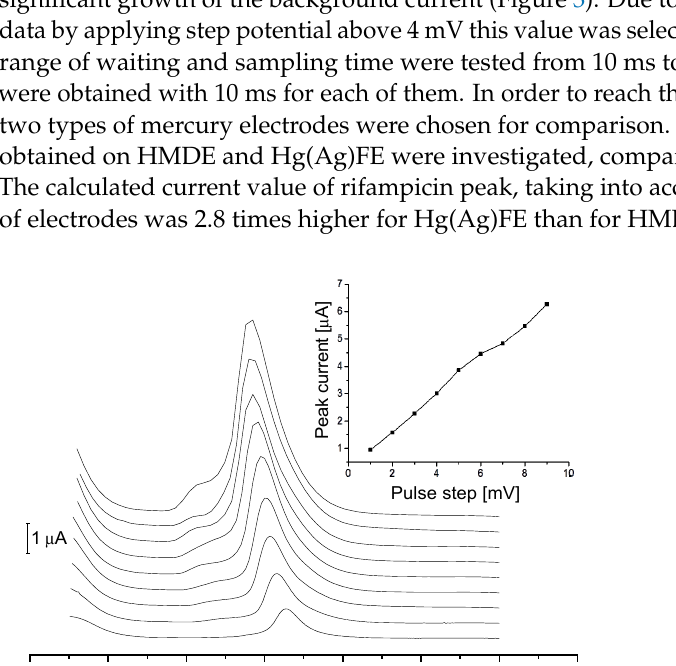
–400 Figure 4. Rifampicin peaks obtained on two types of electrodes: HMDE (1.6 mm 2 ) and Hg(Ag)FE (5.7 mm 2 ) in 0.1 M CH 3 COOH with the same instrumental parameters applied. 3.3. Influence of the Surface Area of the Hg(Ag)FE Electrode on Rifampicin Peak The solid electrode surface areas are usually greater than those of conventional mer- cury drop electrodes. However, when using the Hg(Ag)FE as a working electrode, its sur- face can be easily adjusted over a wide range. The rifampicin peak heights were linearly dependent on the surface area of the working electrode (Figure 5). The linear relationship was described by following parameters: slope, 0.175 ± 0.004 [µA mm − 2 ]; intercept, − 0.240 ± 0.027 [µA] and Pearson correlation coefficient, r = 0.9996. The size of the working elec- trode of 10.9 mm 2 was selected for further studies.